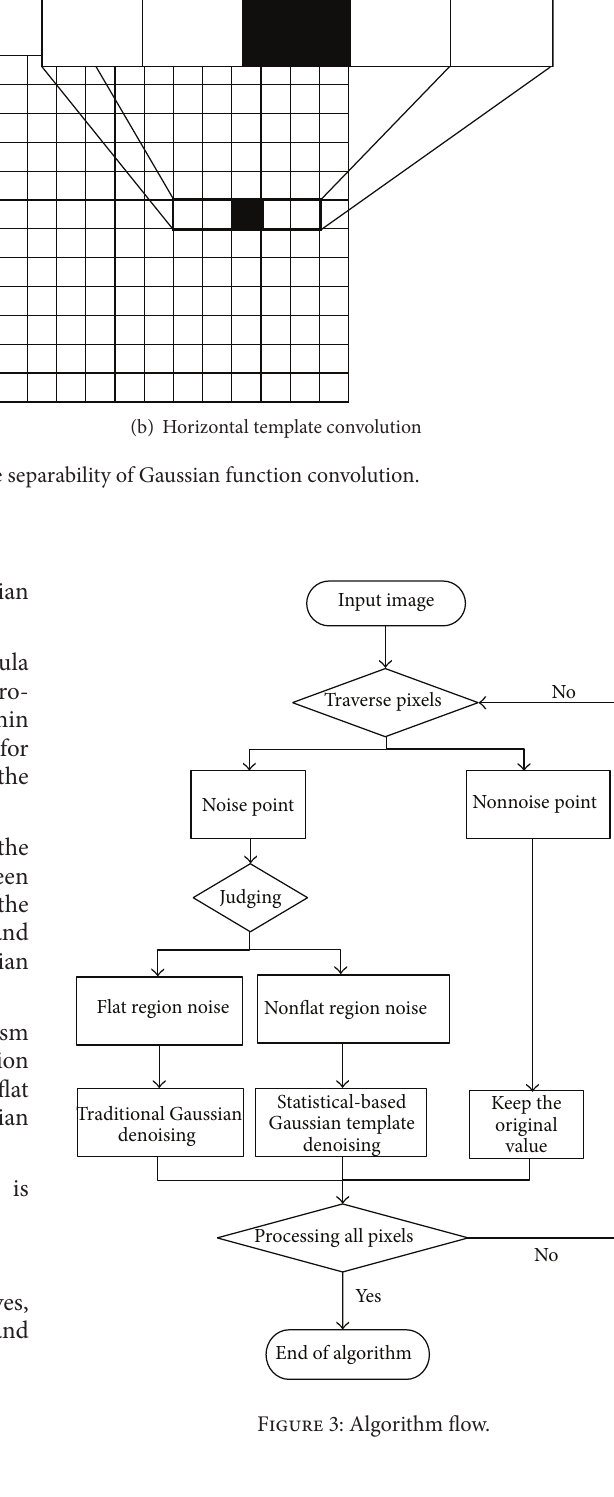
Gaussian denoising, and the method proposed in this paper. Image RMSE (root mean square error) and PSNR (peak signal to noise ratio) were calculated, so as to evaluate the performance of different